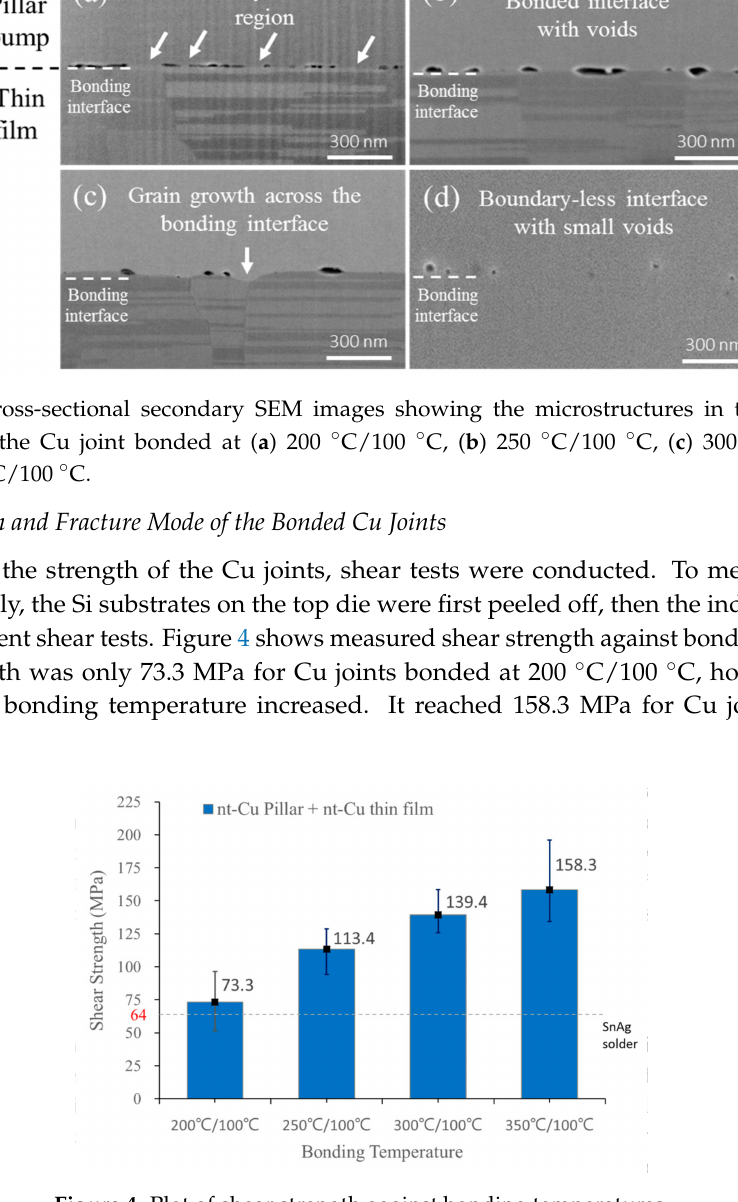
Figure 4. Plot of shear strength against bonding